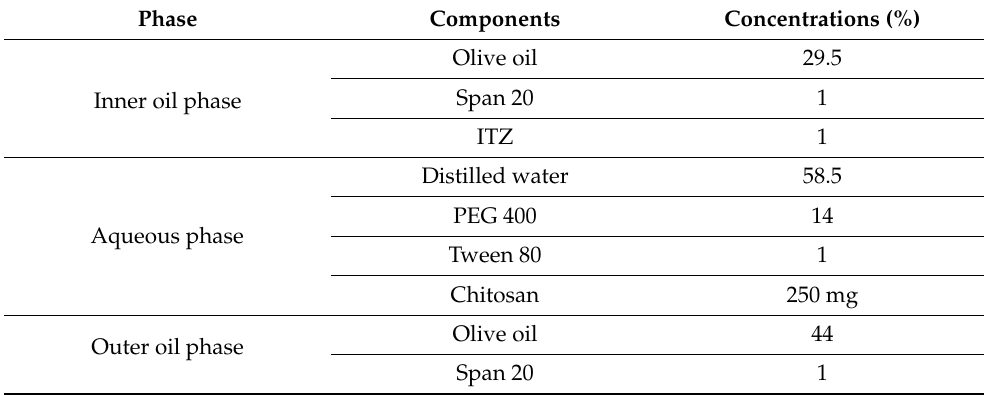
Table 1. Composition of multiple